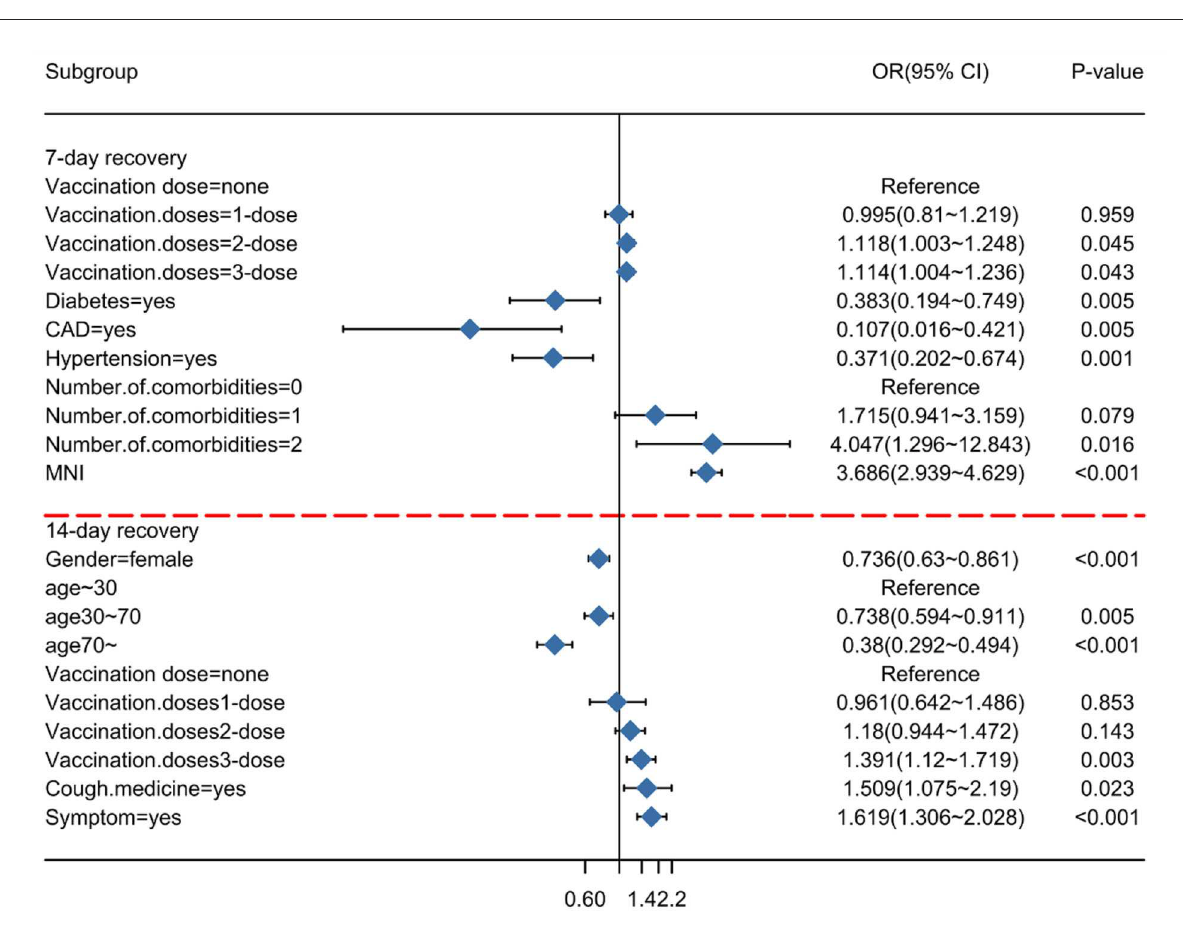
FIGURE3 Subgroup analysis of Omicron infection recovery. An odds ratio of < 1 implies a lower risk of recovery on the indicated